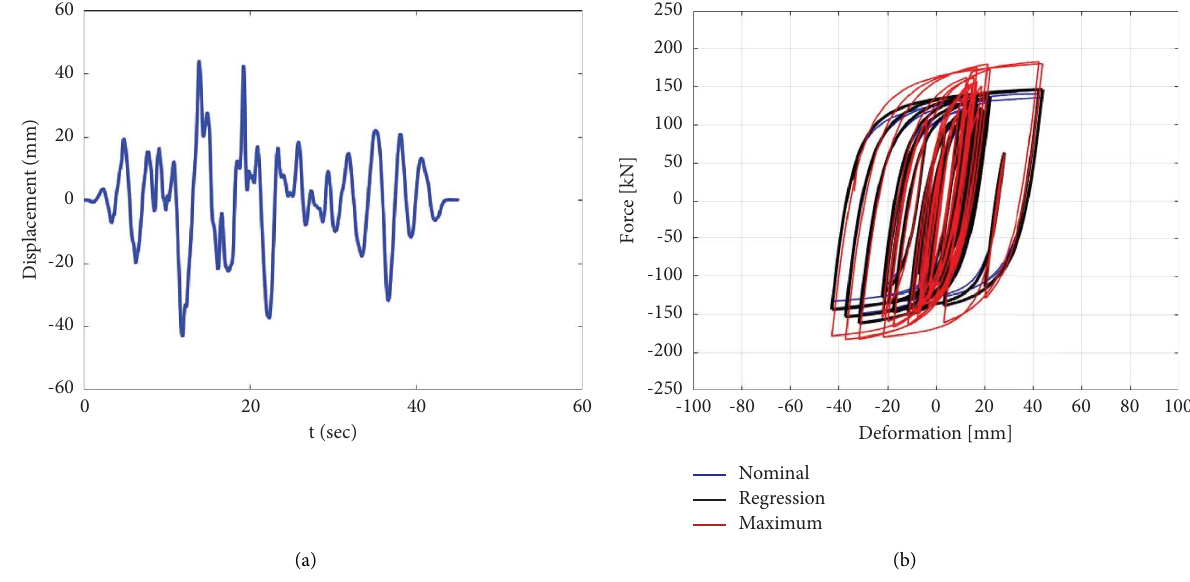
Figure 8: ID1057: applied displacements (a) and hysteresis curves (b).